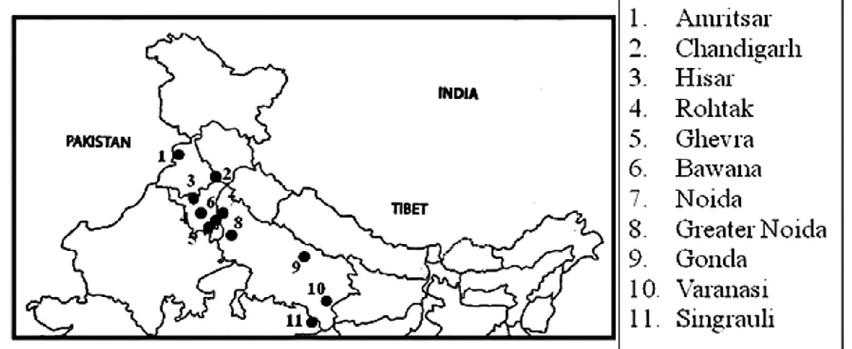
Fig. 1. Sites of sample collection in North India screening and isolation of environmental